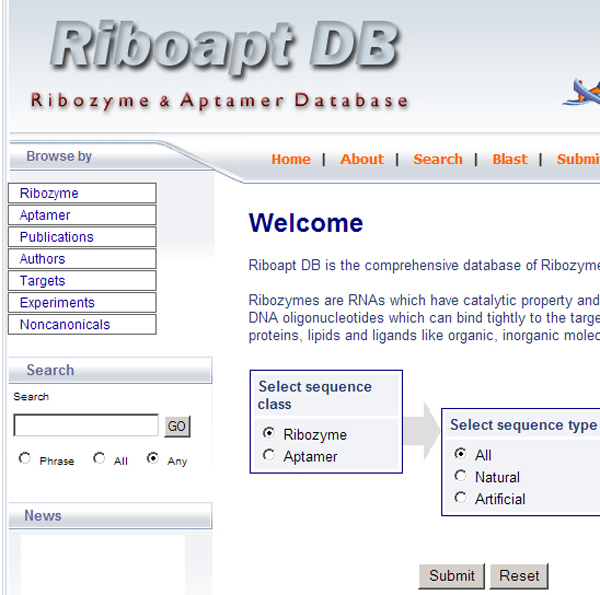
Screenshot of the homepage of the RiboaptDB, an user friendly interface for the database.